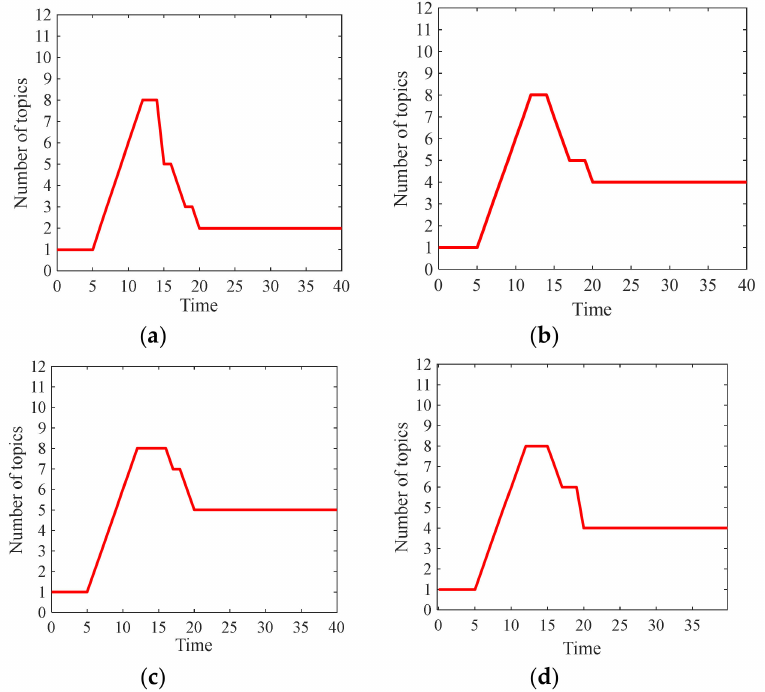
Figure 21. The change of the number of topics under different distributions of